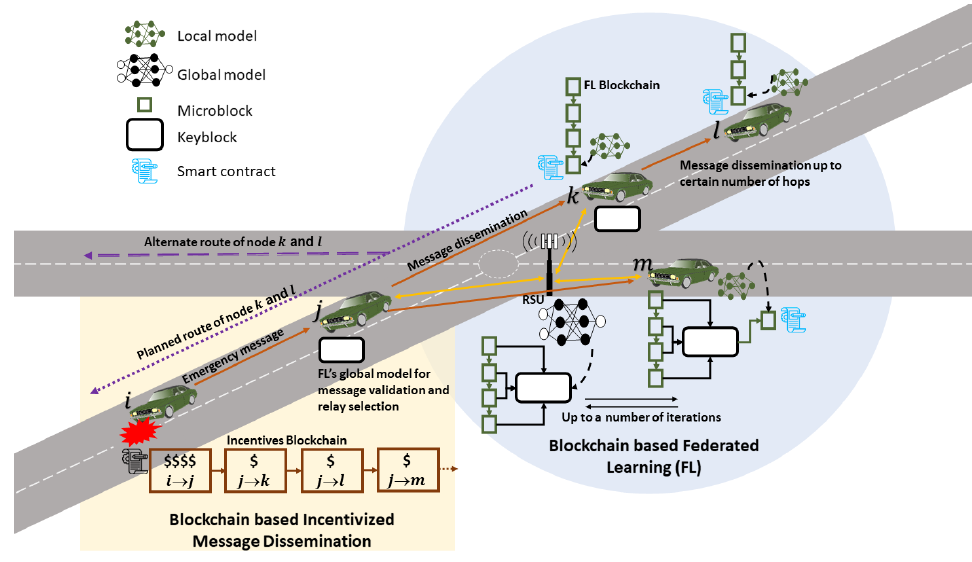
Figure 1. Blockchain-enabled FL and message dissemination in the